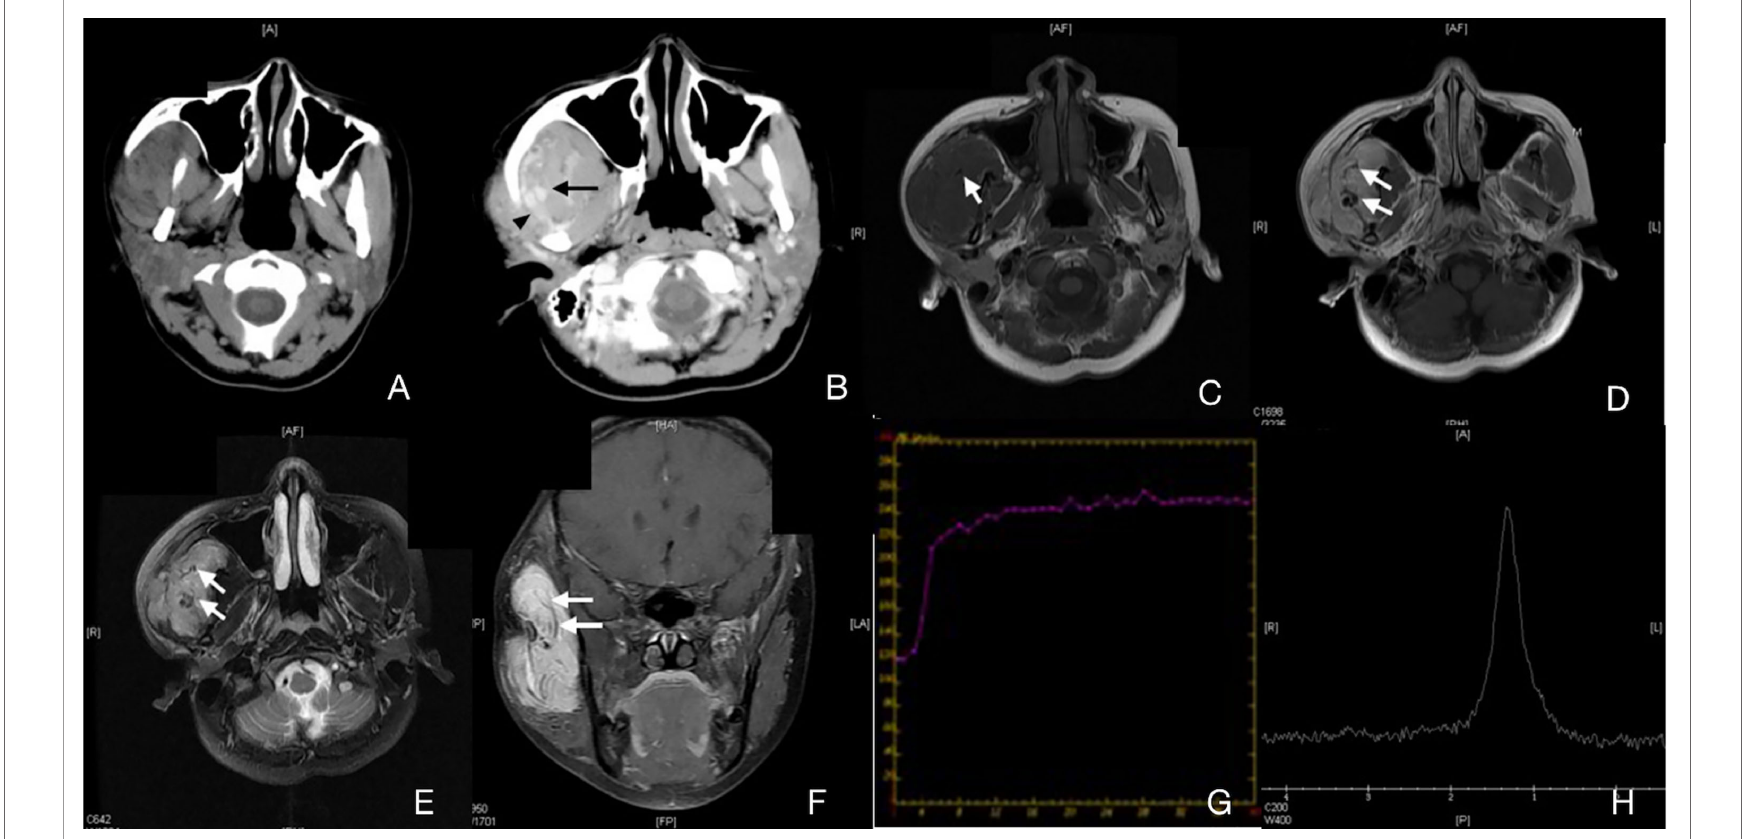
FIGURE 2 | Case 4 ( Supplementary Table 1 ), capillary IMHs. (A) Axial CT image showing an enlarged right masseter with uneven attenuation. (B) Axial enhanced CT image showing an apparently enhanced vermicular vessel (arrow) and an enlarged regurgitant vein (arrowhead). (C) Axial T1WI showing a lesion with an intermediate signal intensity and a vague border. (D) Axial T2WI showing a lesion with a slightly high signal intensity and a blurred border. (E) Axial enhanced fat suppressed T1WI showing an unevenly enhanced lesion in the right masseter. (F) Coronal enhanced fat suppressed T1WI showing a diffuse, irregular lesion with low signal intensity and a striped structure. This structure can also be found in panels (C – E) . (G) TIC analysis showed quick wash-in and slow washout. (H) MRS showing no Cho peak at 3.2